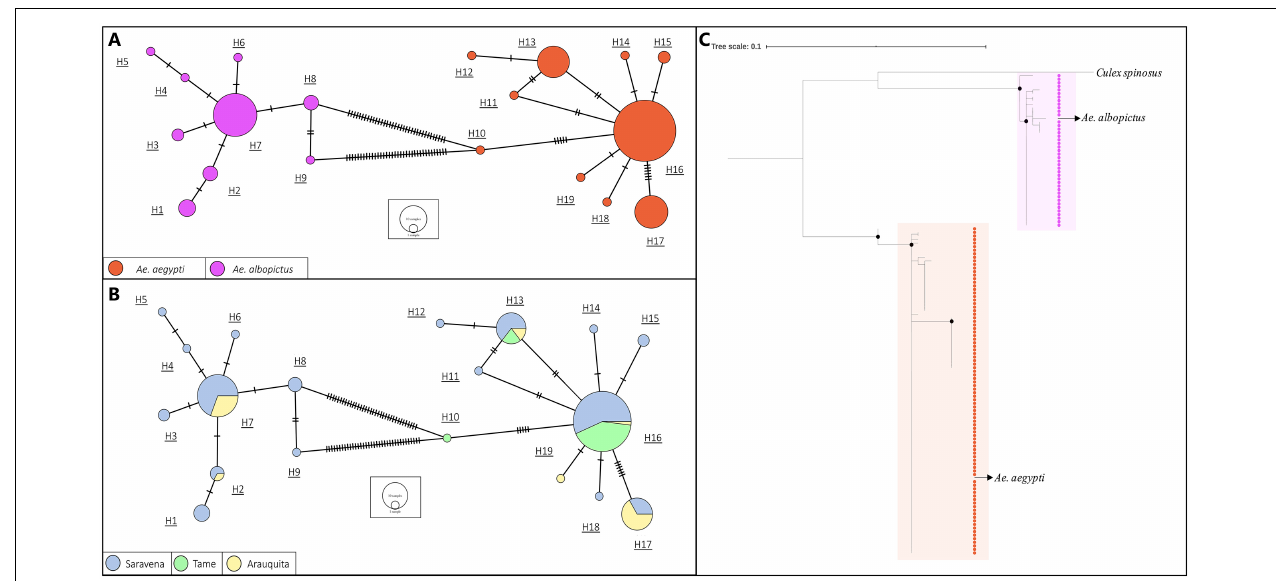
FIGURE 3 | The haplotype network based on sequences of A. aegypti and A. albopictus collected in municipalities of the department of Arauca and colored by (A) species and by (B) collection municipality. The lines in each branch indicate the number of mutational steps between haplotypes, and the size of the circle is proportional to the number of individuals. (C) A maximum likelihood tree based on the JC model of A. aegypti and A. albopictus indivuduals from each place where they were collected. Black dots indicate support bootstrap ≥ 90.